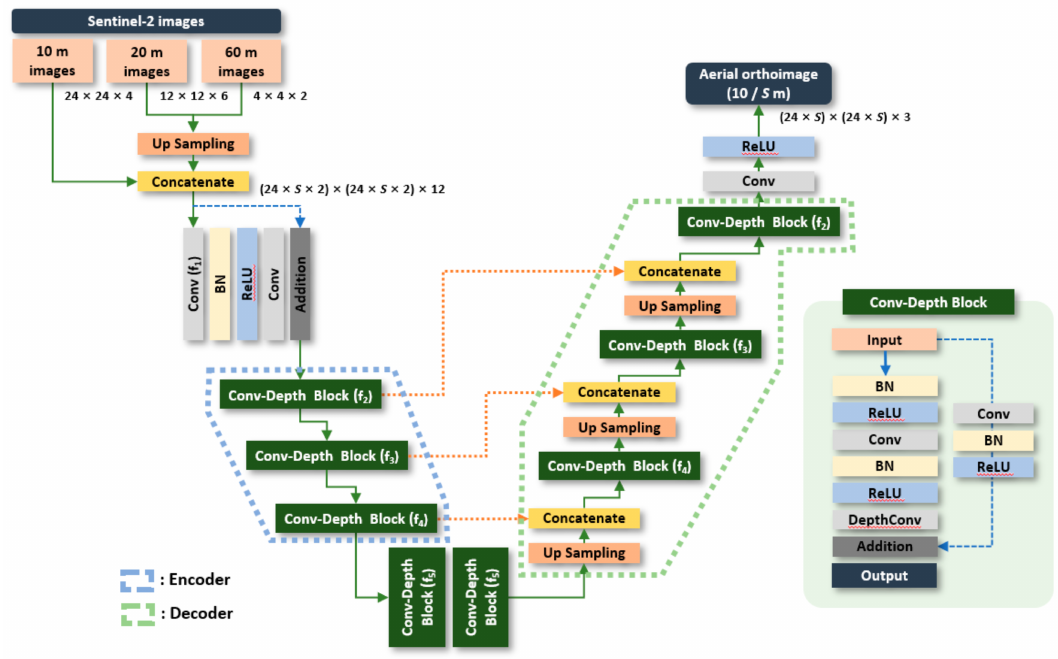
Figure 5. Context-based residual U-net for aerial images simulation ( S : scale, f : feature dimension) .